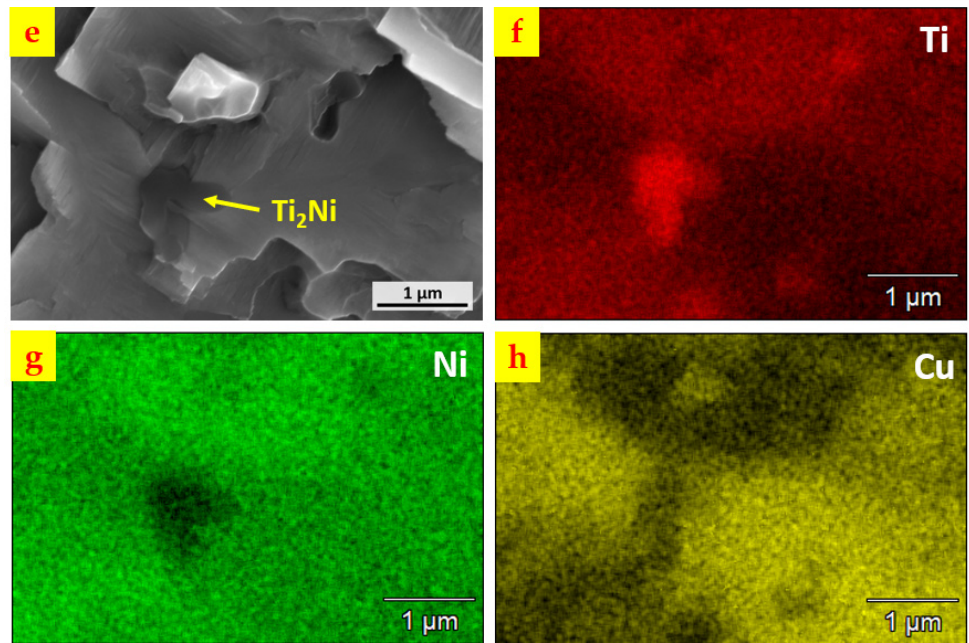
Figure 9. ( a , b ) Dimple-like ductile area of the fracture surface. ( c , d ) Brittle area of the fracture surface. ( e ) High magnification image of ( d ) in long, dashed rectangular box. ( f ) Element mapping of Ti in ( e ). ( g ) Element mapping of Ni in ( e ). ( h ) Element mapping of Cu in ( e ).